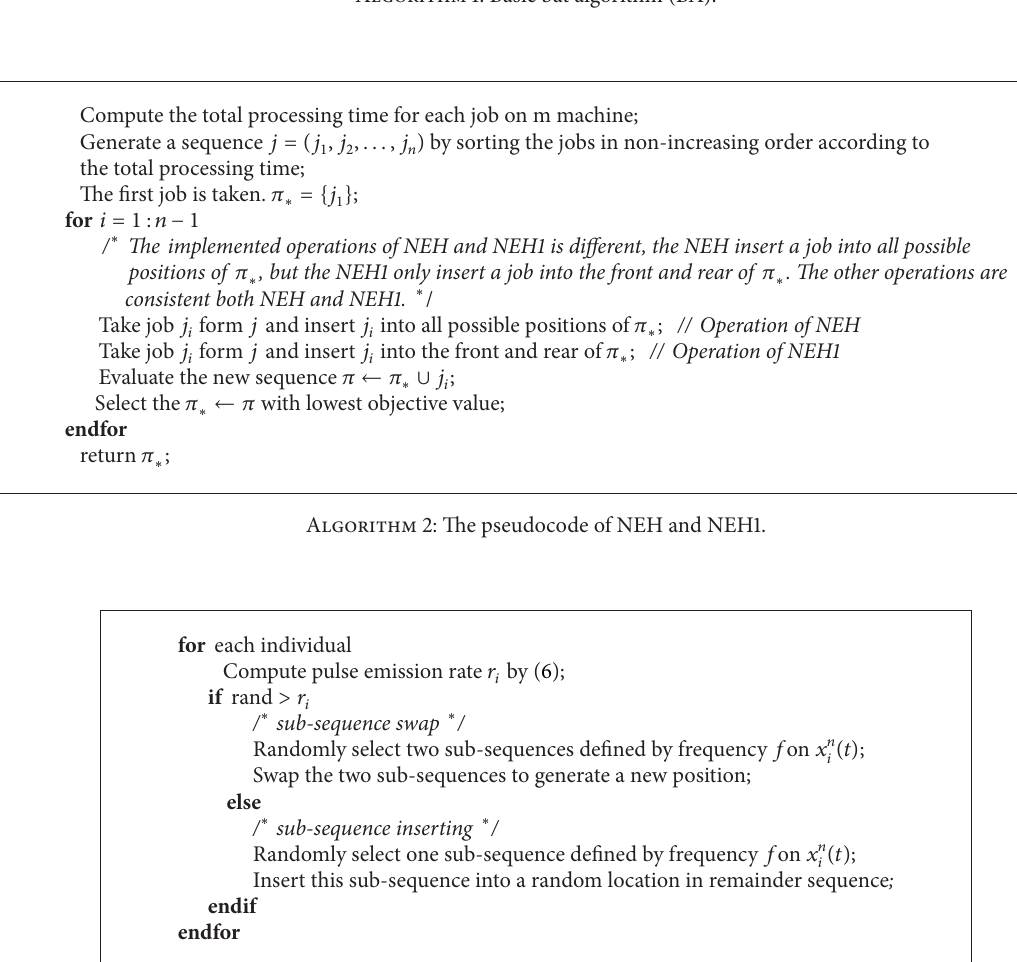
Algorithm 1: Basic bat algorithm (BA).